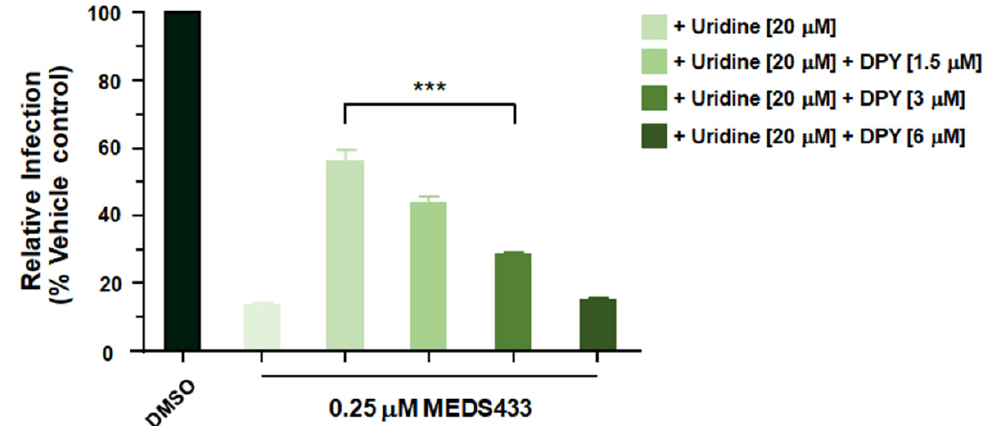
Figure 6. A combination of MEDS433 and dipyridamole hampers SARS-CoV-2 replication even in the presence of uridine. Calu-3 cells were treated with vehicle (DMSO) or 0.25 µ M of MEDS433 in the presence of 20 µ M uridine alone or in combination with different concentrations of DPY before and during SARS-CoV-2 infection (100 PFU/well). Following virus adsorption, cell monolayers were incubated in the presence of compounds. At 48 h p.i., cell supernatants were harvested and titrated for infectious SARS-CoV-2 on Vero E6 cell monolayers. The data shown represent means ± SD (error bars) of three independent experiments performed in triplicate. Statistical significance was calculated by a one-way ANOVA followed by Dunnett’s multiple comparison test. *** ( p < 0.0001) compared to the calibrator sample (MEDS433 alone).